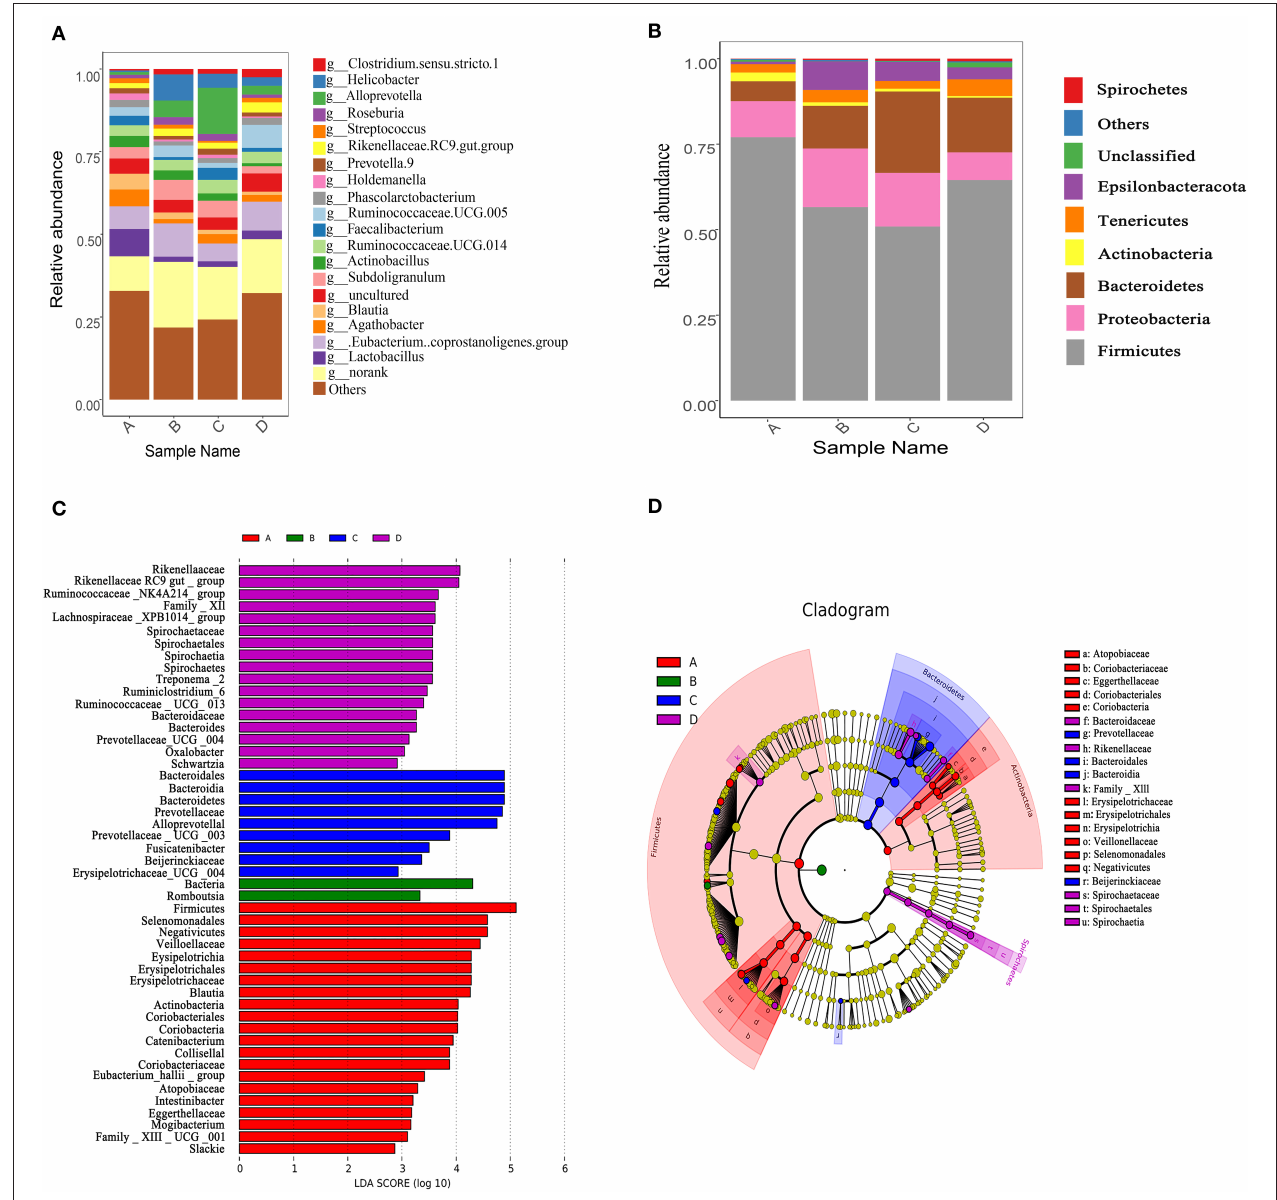
FIGURE 5 | Changes of caecum microbiota compositions of weaned piglets fed with or without dietary bacteriophage ( n = 5). (A) The relative abundance of caecum microbiota composition at the phylum level. (B) The relative abundance of caecum microbiota composition at the genus level. (C) Cladogram and LDA value distribution histogram. Sample name A: the control diet supplemented with 25 mg/kg quinocetone and 11.25 mg/kg chlortetracycline in the basal diet; Sample name B: 200 mg/kg bacteriophage diet; Sample name C: 400 mg/kg bacteriophage diet; Sample name D: 600 mg/kg bacteriophage diet. The bacterial taxa were significantly differentiated between the bacteriophage group and the control group using linear discriminant analysis coupled with effect size (LEfSe) with the default